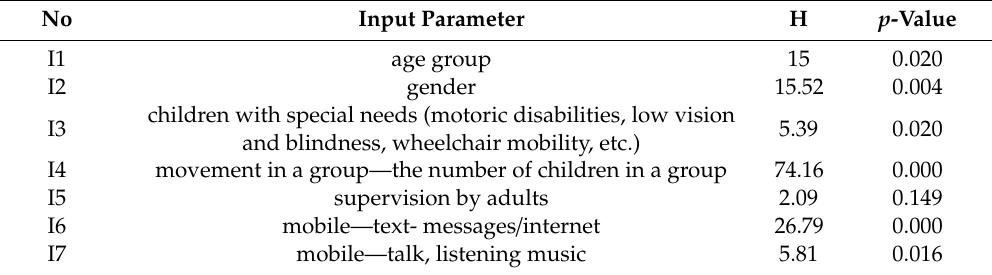
Table 5. Results obtained using the nonparametric Kruskal–Wallis test.